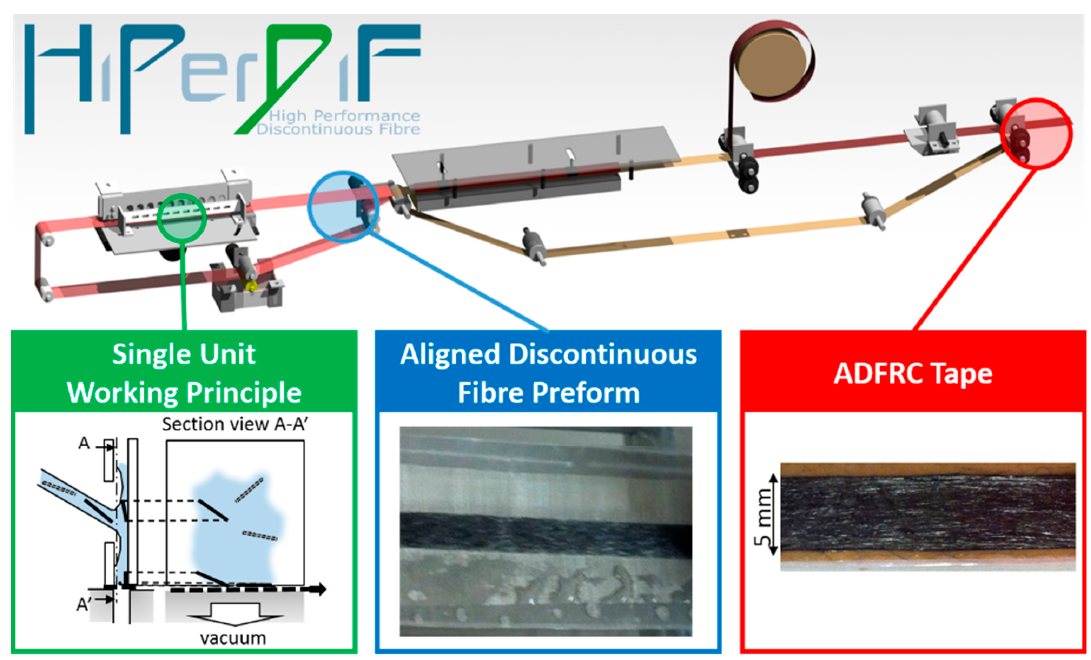
Figure 1. The HiPerDiF fibre alignment machine.